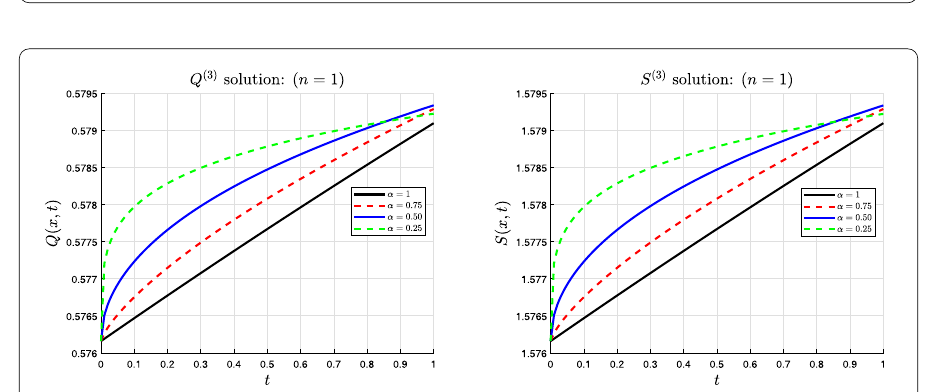
Figure 15 Nature of q-HATM solution with different α when (cid:2) = –1, k = η = 0.1, r = –1.5, p = 1.5, and x = 10 for Example 4.1